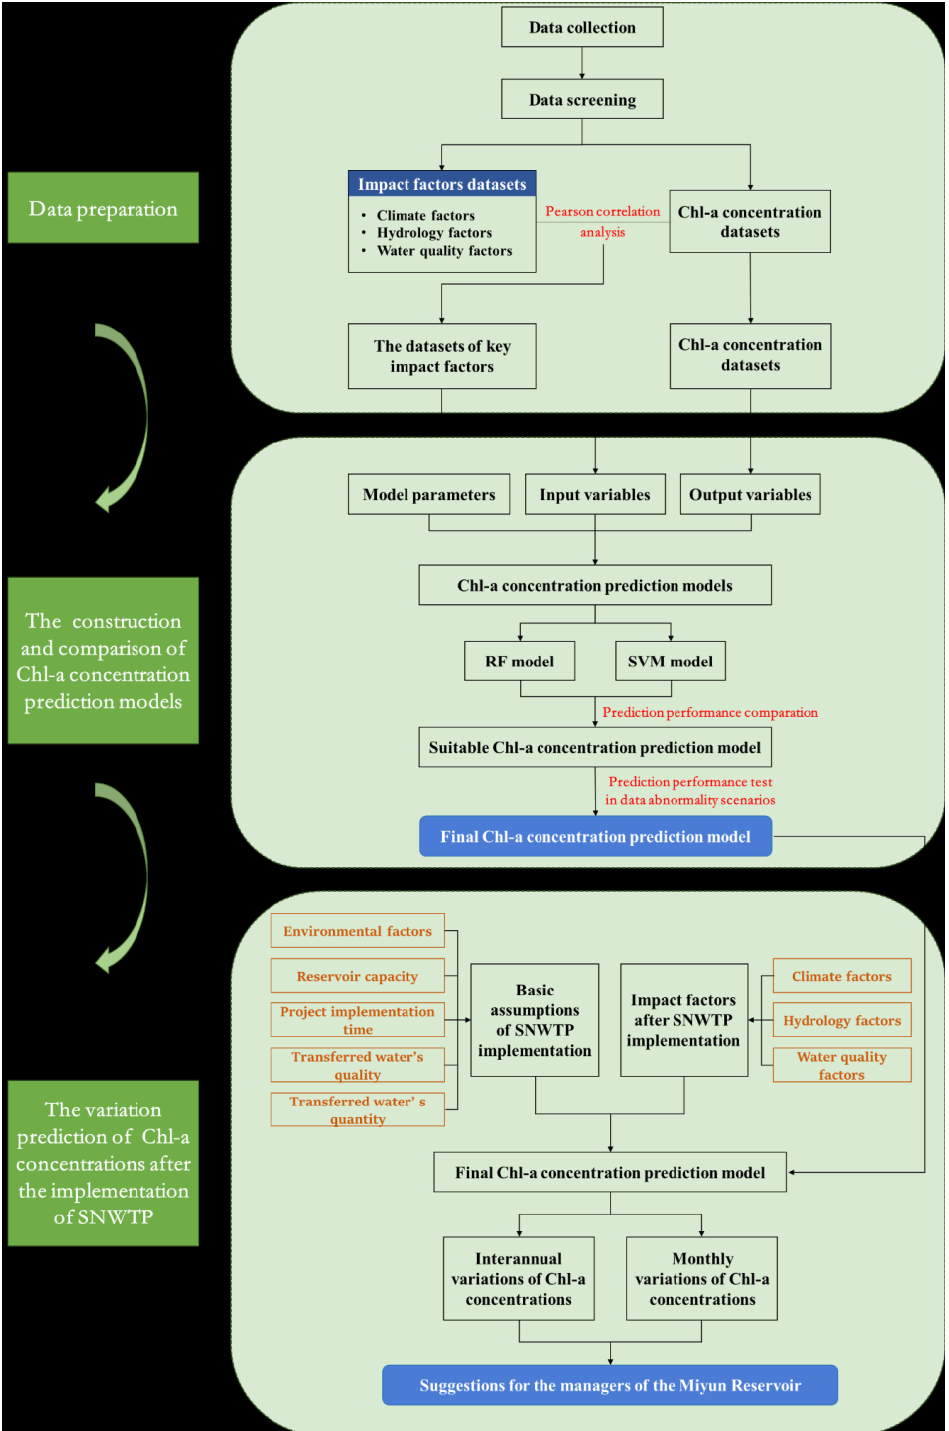
Figure 2. Technical roadmap for predicting Chl-a variations in the receiving reservoir of the water transfer